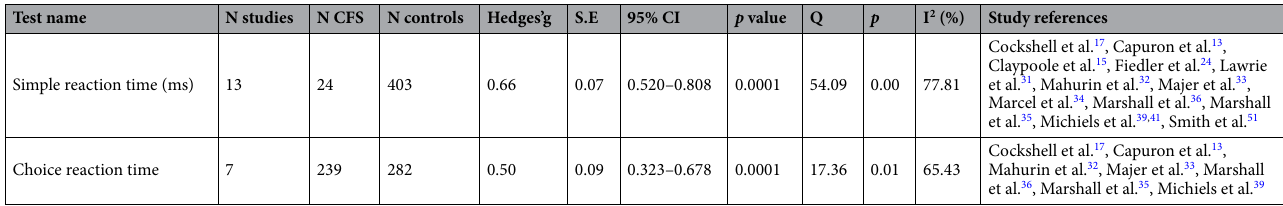
Table 3. Reaction time: Hedge’s g effect sizes for each test, in descending order. ME/CFS myalgic encephalomyelitis/chronic fatigue syndrome, N number.